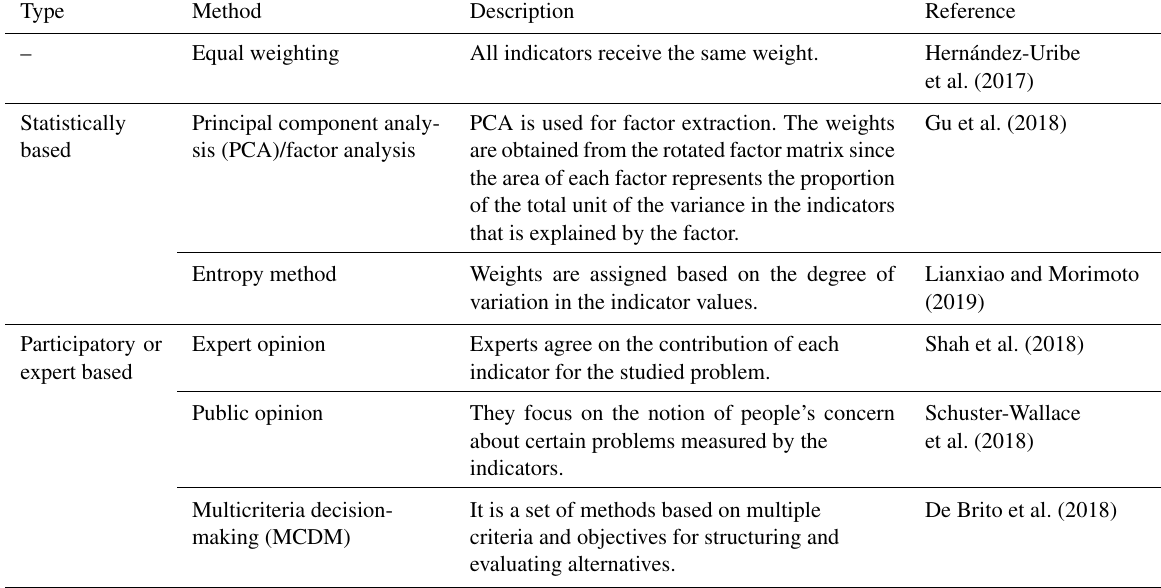
Table 2. Characteristics of the main weighting methods used for building indices.